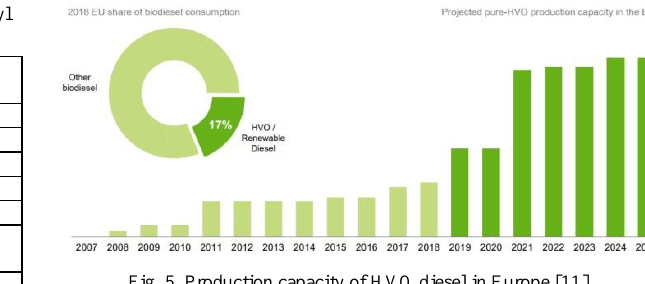
Fig. 5. Production capacity of HVO diesel in Europe [11] HVO fuel is already known, manufactured and used in some European countries. These countries chose the Green Diesel fuel because of its favorable properties such as low freezing temperature, and also because of the possibility of exceeding the so-called "blend wall", meaning the threshold for the maximum amount of biodiesel that can be mixed with diesel. The concept of "blend wall" stands for the quality specifications of fuels issued by engine manufactur- ers.